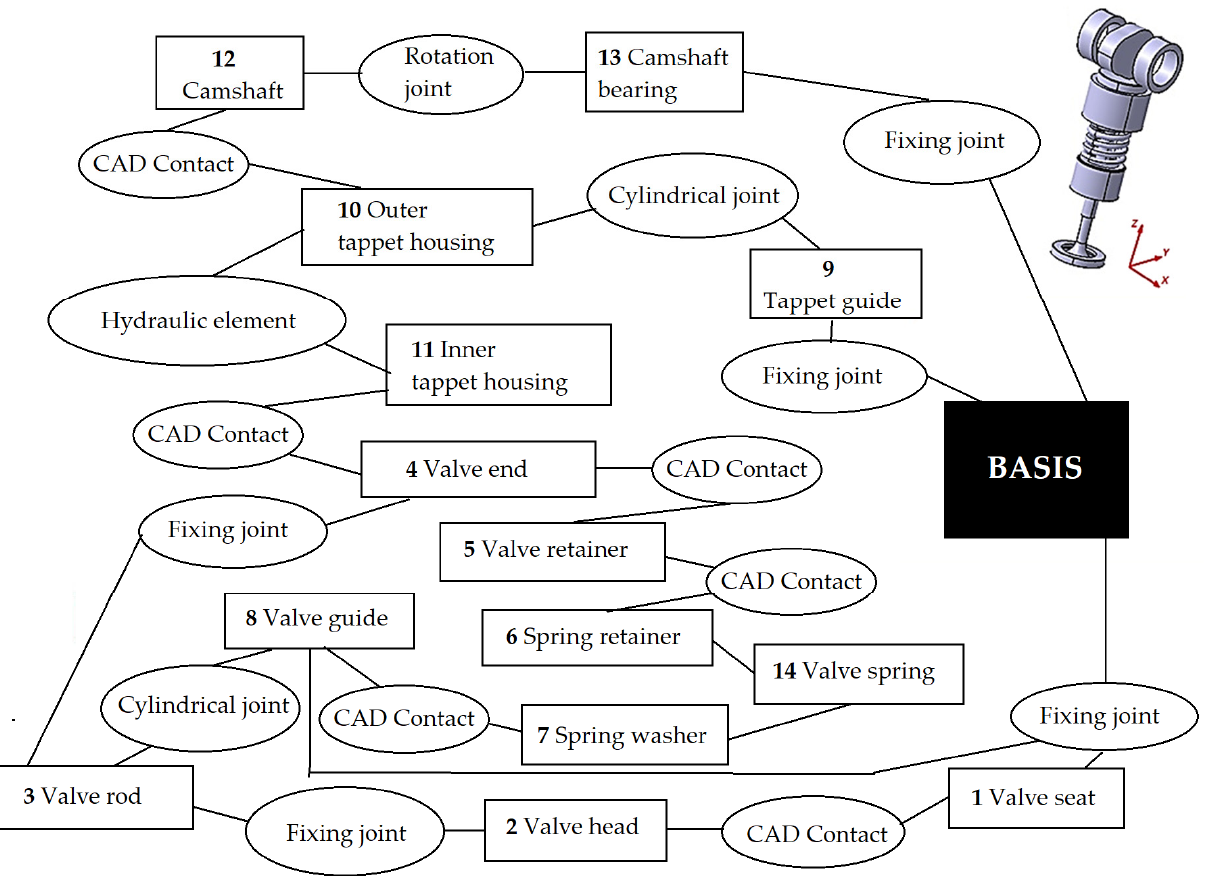
Figure 4. Diagram of the virtual model of the valvetrain mechanism.